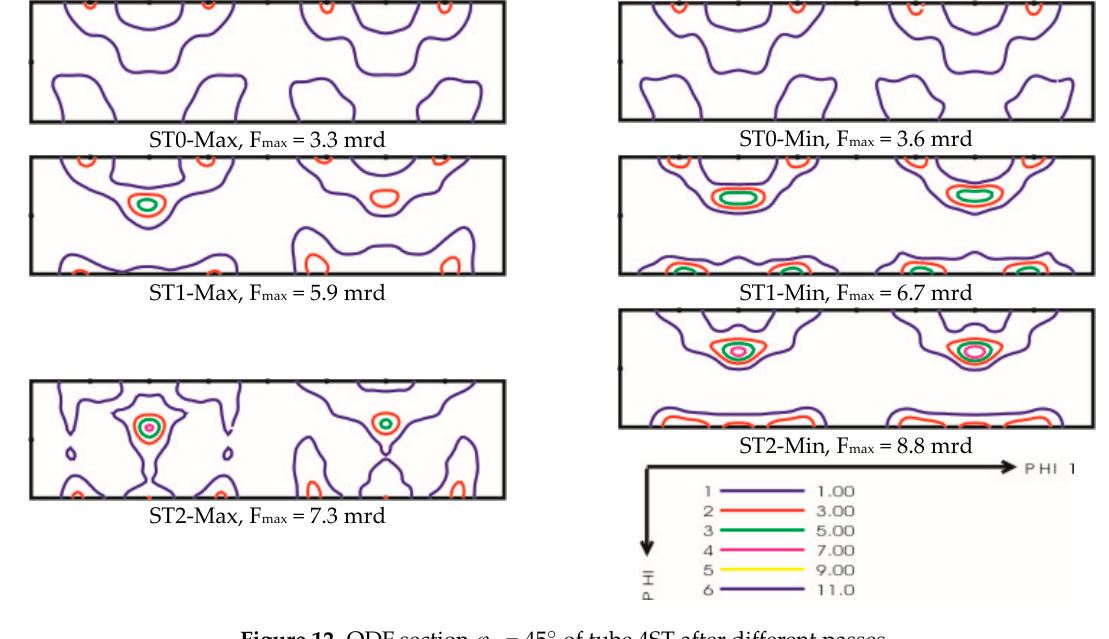
Table 4. Cube, copper and S components for tube 4 (all units in mrd).